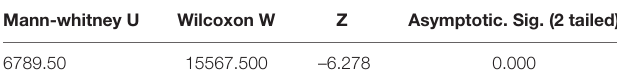
TABLE 2 | The reliability statistics for the three questionnaires of the survey. Survey sections